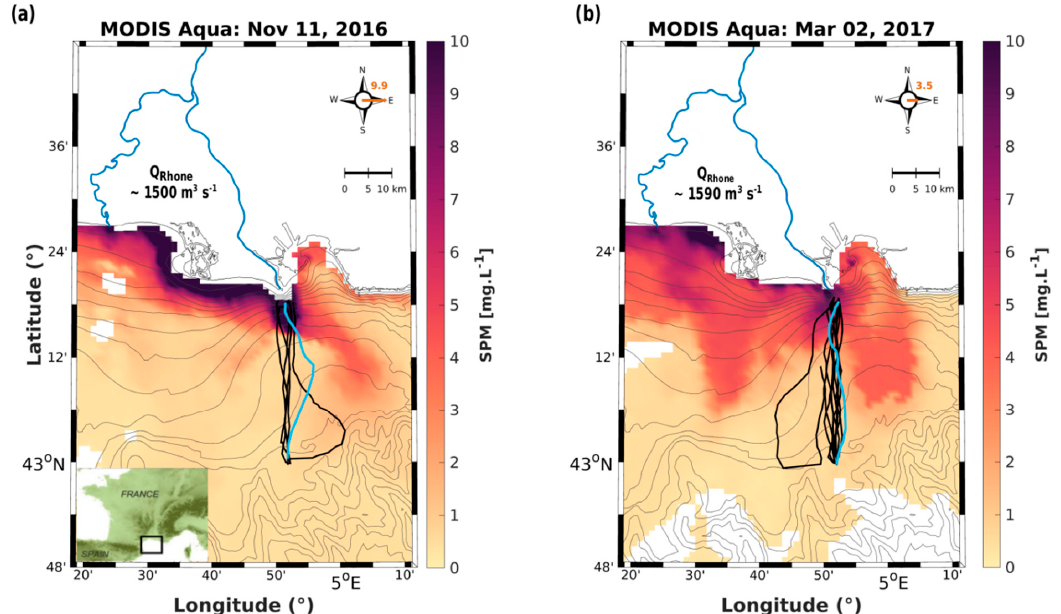
Figure 1. Moderate Resolution Imaging Spectroradiometer (MODIS) Aqua images of suspended particulate matter (SPM) concentration for ( a ) November 11th 2016, with a flow from the Rhone River of about 1500 m 3 s − 1 and ( b ) March 2nd 2017, with a flow of about 1590 m 3 s − 1 . Clouds are shown as white patches and wind speed (in m s − 1 ) and direction are specified. Depth contours are shown in gray and represent the 10 m isobaths from the coast. The glider track and sections of interest are shown as thick black and blue lines, respectively, for each deployment.